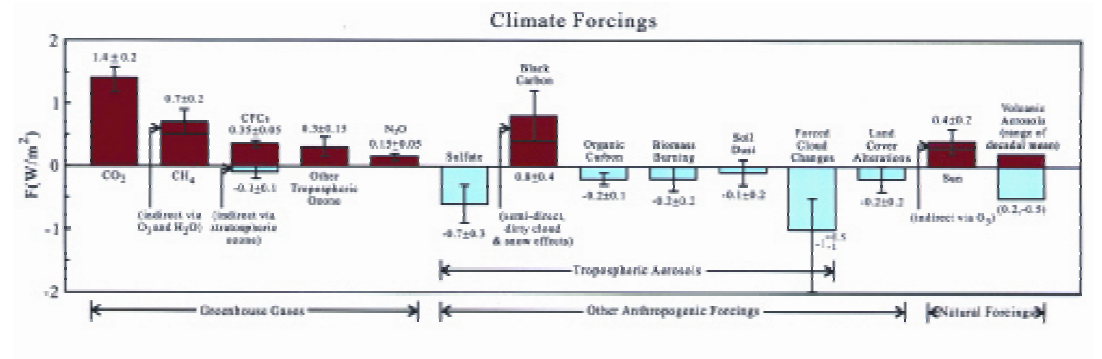
FIGURE 19. Estimated change of climate forcings between 1850 and